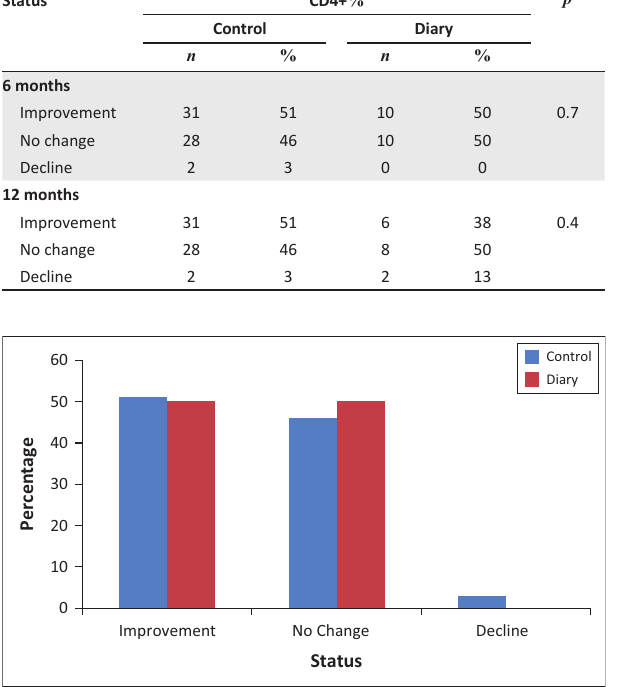
FIGURE 3: CD4+ % response at 6 months for both groups.